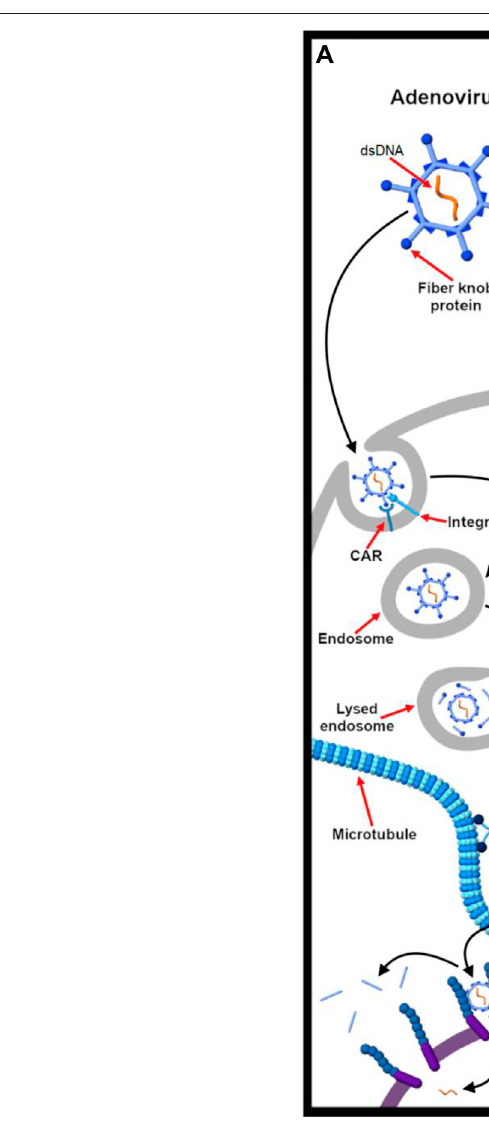
dynactin motor proteins to hitchhike towards the nucleus. As the viral capsid docks onto the nuclear pore complex (NPC), the kinesin motor mediates a tug-of-war processfor fi naluncoatingoftheviralcapsidandreleaseoftheviralgenome(SchererandVallee2011). (B)